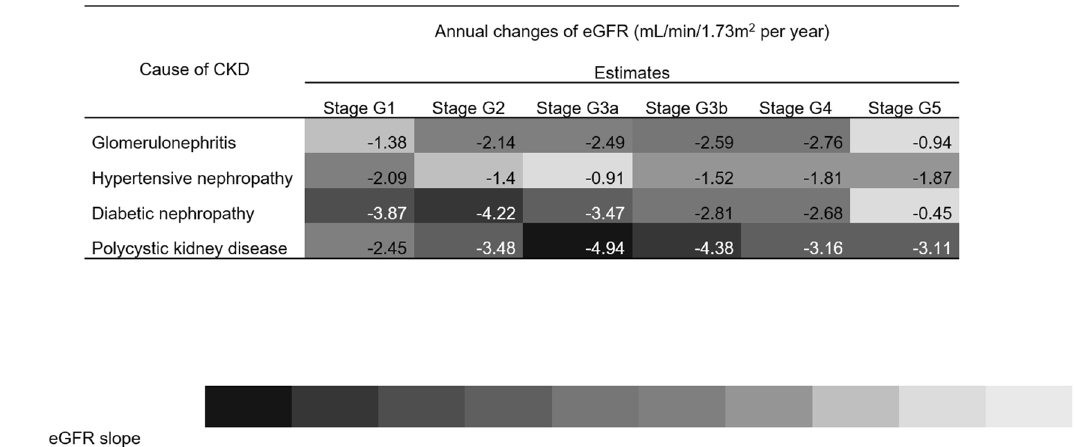
Figure 2. Estimated glomerular filtration rate changes according to baseline CKD stages in each CKD etiology group. CKD of each groups with A1-A3 are classified using eGFR as followed based on KDIGO guideline 30 : stage G1 ≥ 90 mL/min/1.73 m 2 , stage G2 60–89 mL/min/1.73 m 2 , stage G3a 45–59 mL/min/1.73 m 2 , stage G3b 30–44 mL/min/1.73 m 2 , stage G4 15–29 mL/min/1.73 m 2 , and stage G5 < 15 mL/min/1.73 m 2 without kidney